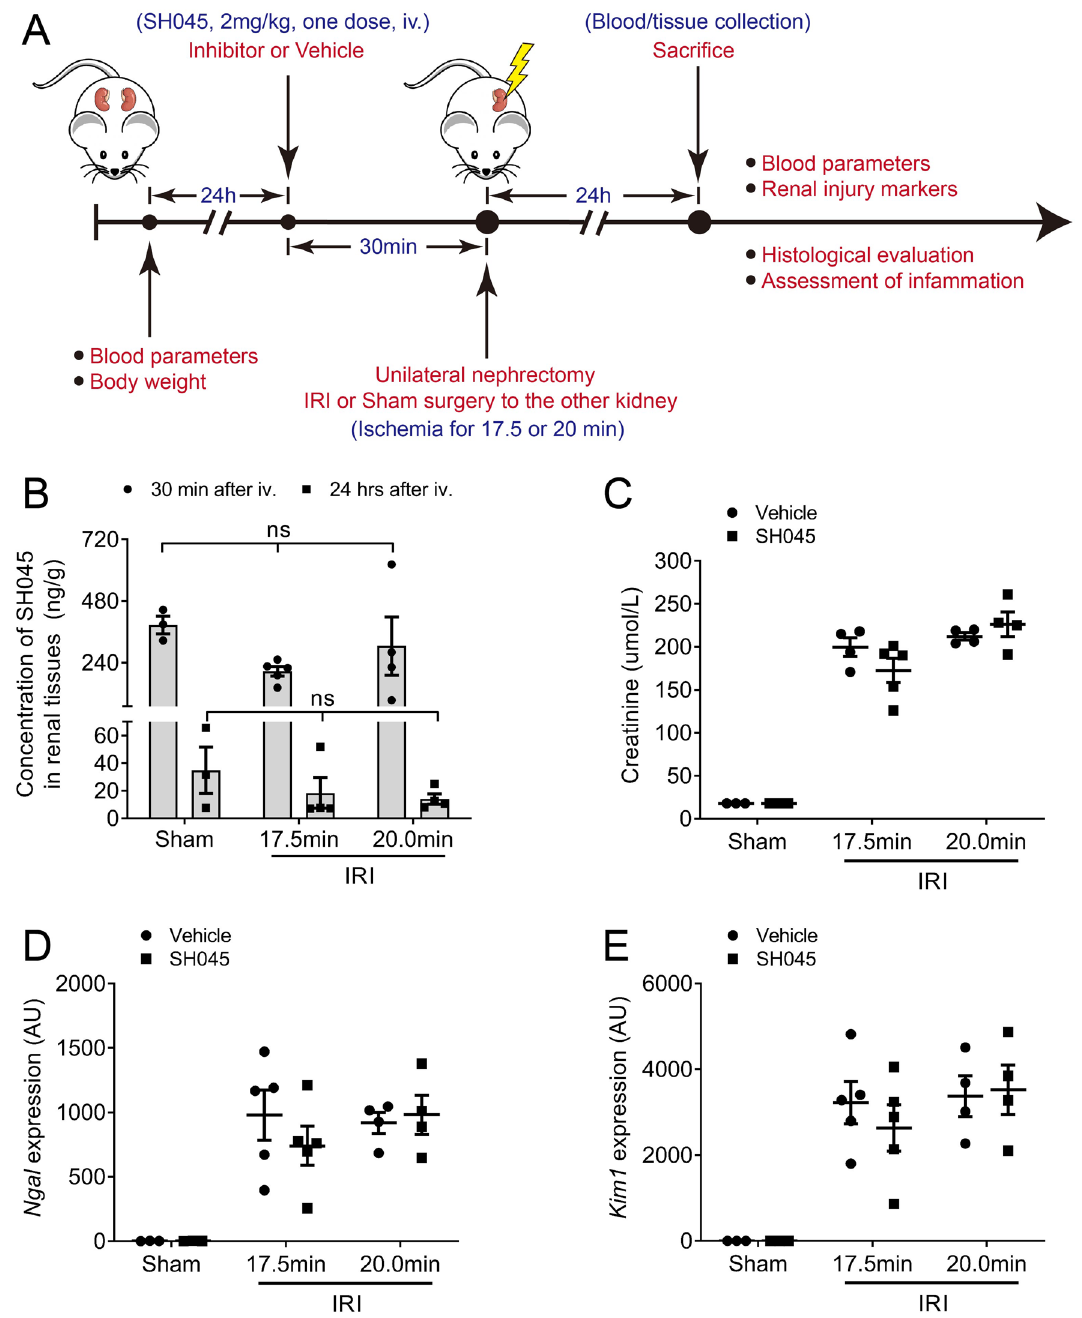
Figure 5. Effect of the TRPC6 inhibitor SH045 on IRI–induced acute kidney injury (AKI). ( A ) Experimental design of IRI–induced AKI. ( B ) Concentrations of SH045 in kidney tissue 30 min and 24 h after intravenous injection (Sham n = 3 each, 17.5 min-IRI in vehicle and SH045 n = 5 each, 20 min-IRI in vehicle and SH045 n = 4 each, respectively). ( C ) Serum creatinine levels (Sham n = 3 each, 17.5 min-IRI in vehicle and SH045 n = 5 each, 20 min-IRI in vehicle and SH045 n = 4 each, respectively). ( D ) Renal mRNA levels of kidney injury marker neutrophil gelatinase-associated lipocalin ( Ngal ) and ( E ) kidney injury molecule 1 ( Kim1 ) (Sham n = 3 each, 17.5 min-IRI in vehicle and SH045 n = 5 each, 20 min-IRI in vehicle and SH045 n = 4 each, respectively). Please note that at baseline all serum creatinine levels were below the measurement limit (18 µmol/L). Two- way ANOVA followed by Sidak’s multiple comparisons post hoc test. AU arbitrary units. Data expressed as means ±